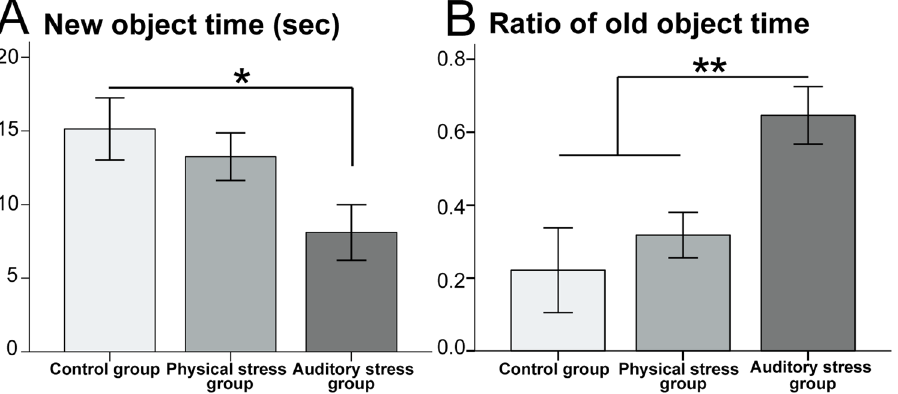
Figure 1. The novel object recognition (NOR) test: ( A ) the auditory stress group significantly spent shorter time with the new object compared with the control group. ( B ) The ratio of time spent with old compared with new object was significantly higher in the auditory stress group than the two other groups. N = 10 in all groups. Results are reported as mean ± S.E.M. Asterisks indicate * p < 0.05 or ** p <